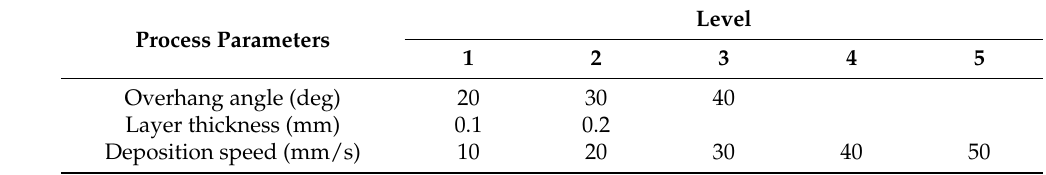
Table 3. Level of process parameters for parametric study.